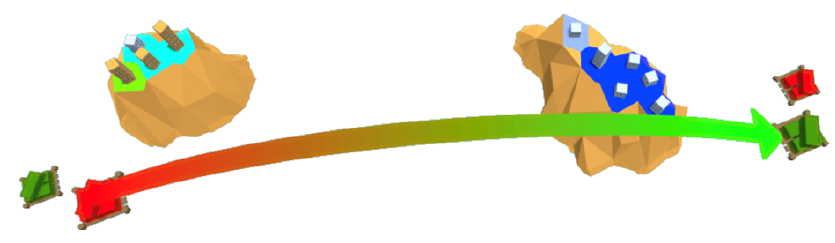
Figure 4. Island metaphore [53].